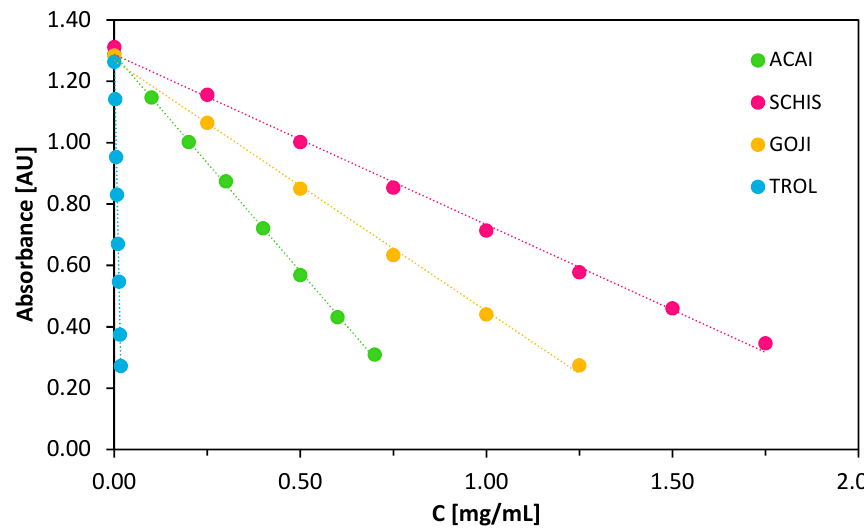
Figure 2. The decrease in ABTS + • absorbance measured at λ max 734 nm in the presence of increasing concentrations of the selected berry extracts and TROLOX after 30 min of reaction at pH 7.4 at 25 °C.